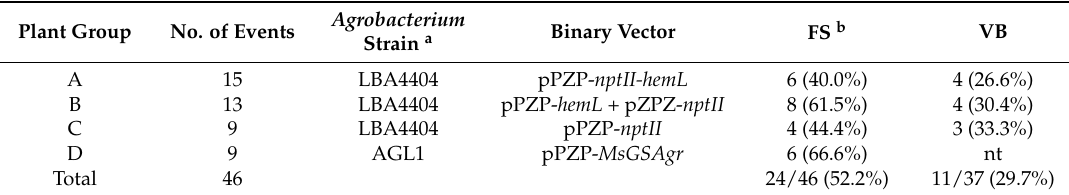
Table 2. Transgenic alfalfa events used for isolating flanking sequences (FS) and assessed for the presence of vector backbone (VB) sequences.